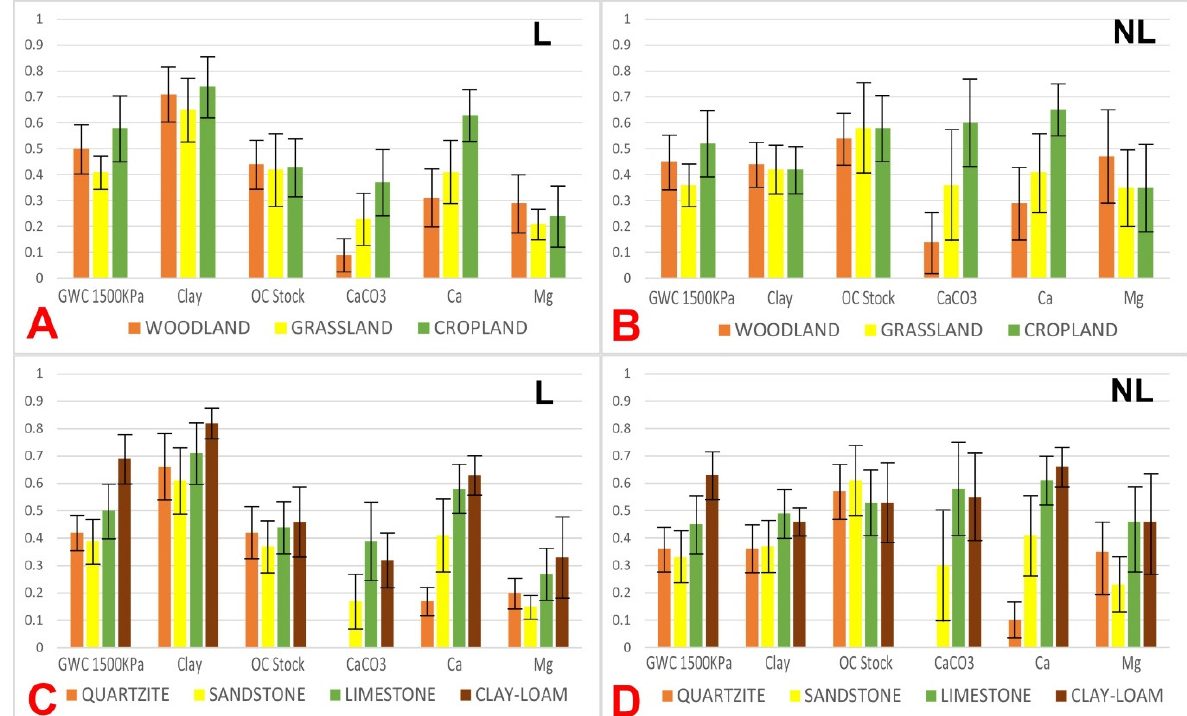
Figure 10. Mean values and standard deviations of the linear (L) and nonlinear (NL) indicators of water retention at field capacity (GWC1500kPa), clay content (Clay), organic carbon stock (OC